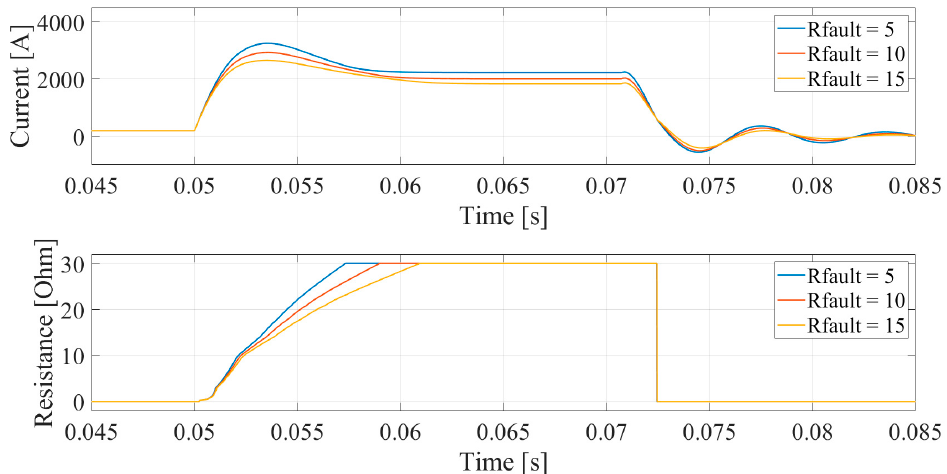
Figure 9. Influence of fault resistance in transition time of RQ model.